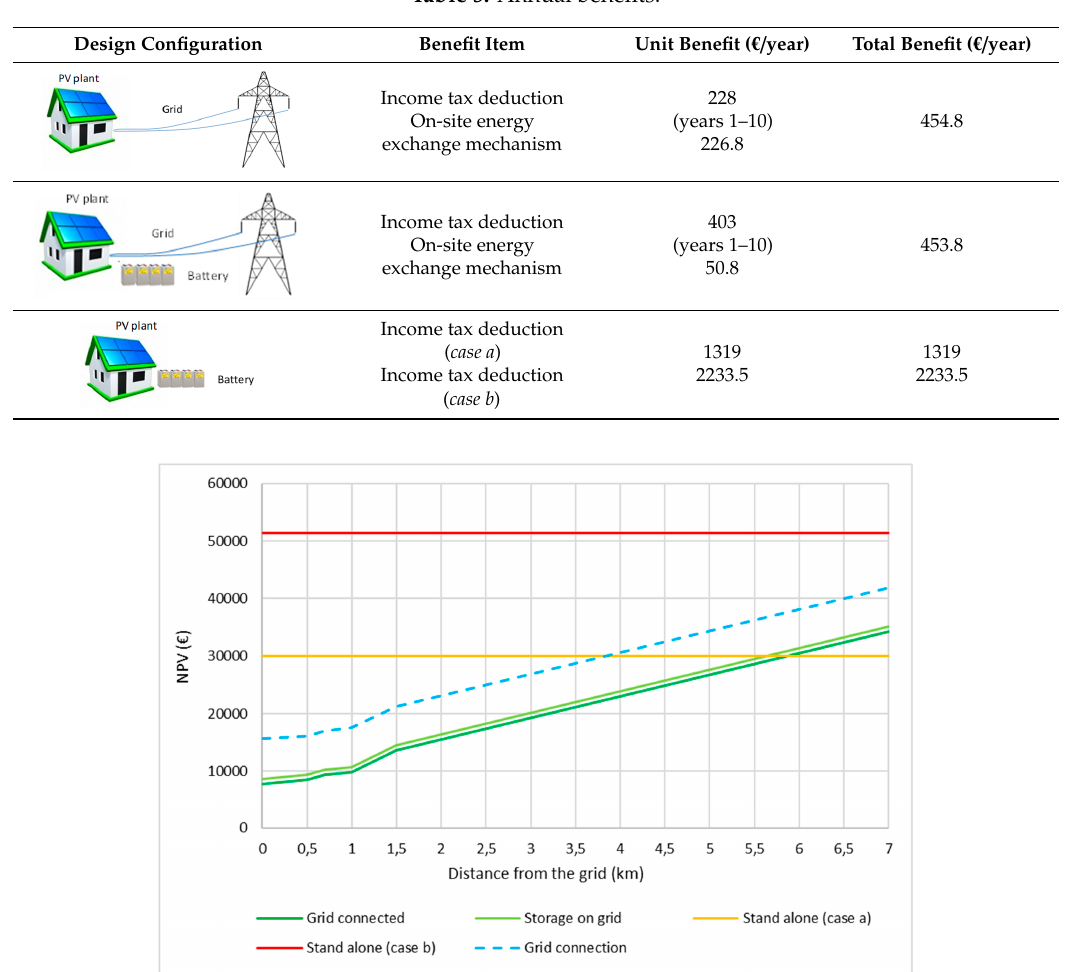
Figure 12. NPV of the configurations.